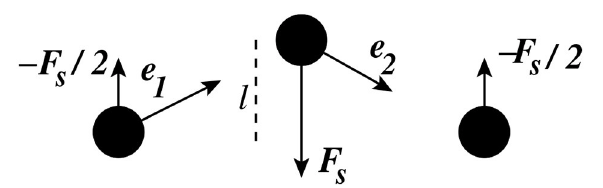
FIGURE 3 | The force F S implementing the stiffness interactions.